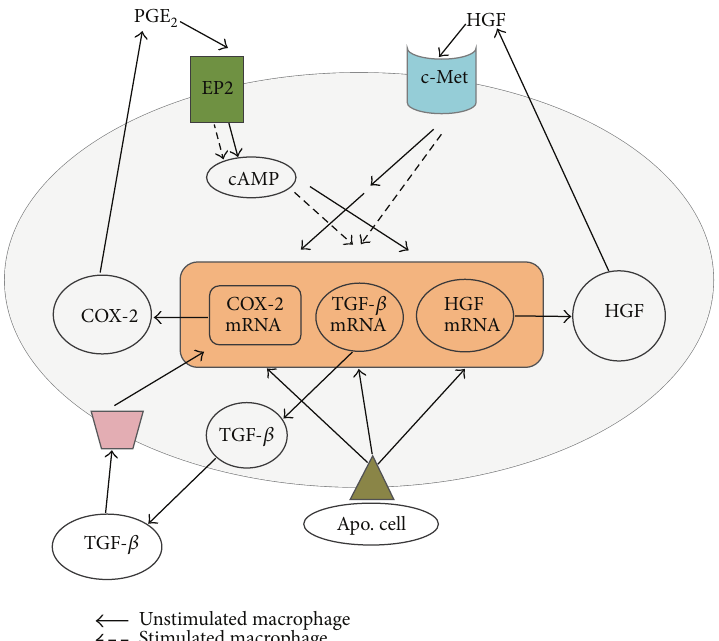
Figure 9: A schematic diagram proposed COX-2/PGE 2 and HGF pathways for a positive feedback loop associated with production of anti- inflammatory cytokine TGF- 𝛽 in response to apoptotic